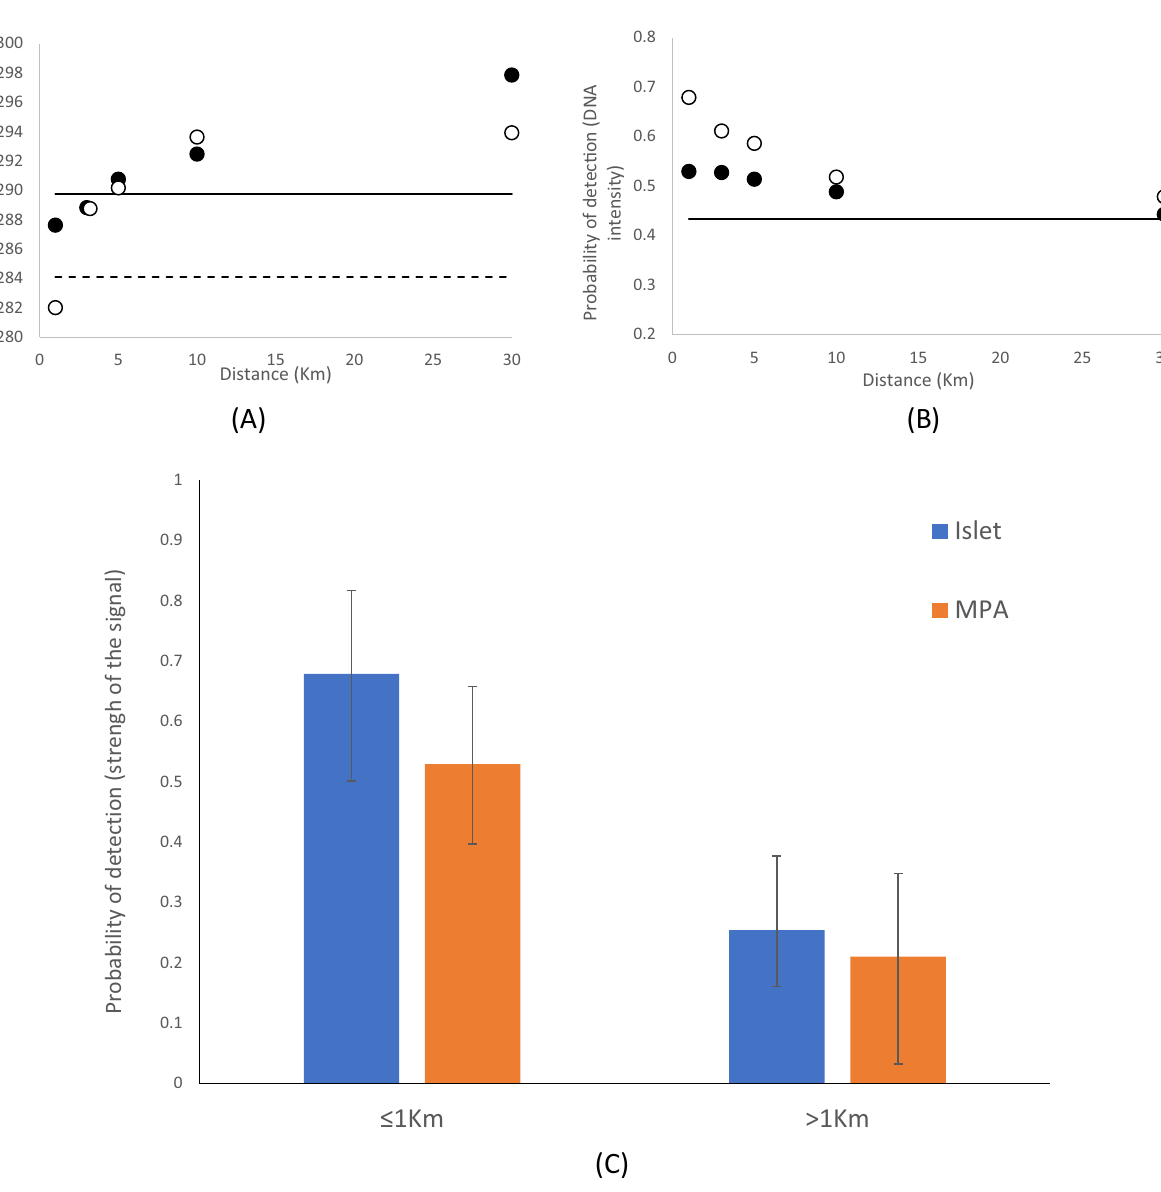
Figure 5. Relationship between incidence of positives and proximity to islets and MPAs. ( A ) AICc of models assuming a threshold value of the distance sets at 1, 3, 5, 10 and 30 km, respectively. Dots are the values for the variable ‘Islet’ (white symbol) and ‘MPA’ (solid symbol). The horizontal lines indicate a difference in AICc > 2 from the retained model of each variable. Threshold values for MPA was at 3 km, while for Islet was 1 km. ( B ) The probability of detection, equivalent to the strength of the eDNA signal, is a negative function of the distance from islets (white symbol) and marine protected areas (solid symbols). The horizontal line indicates the average value. ( C ) Detection probability (strength of the eDNA signal) increases near protected areas and